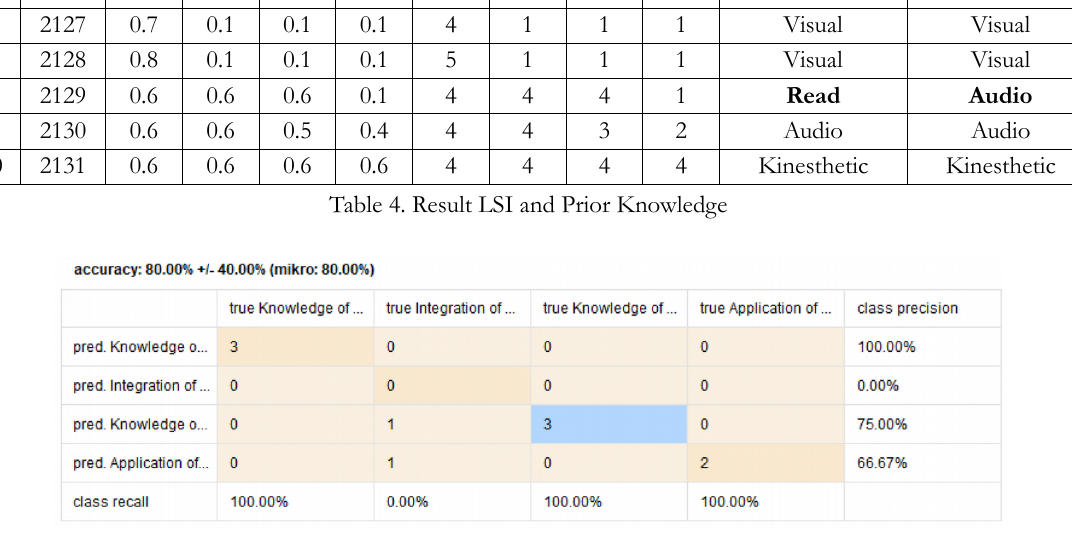
Table 5. Using ANN for Detection Learning